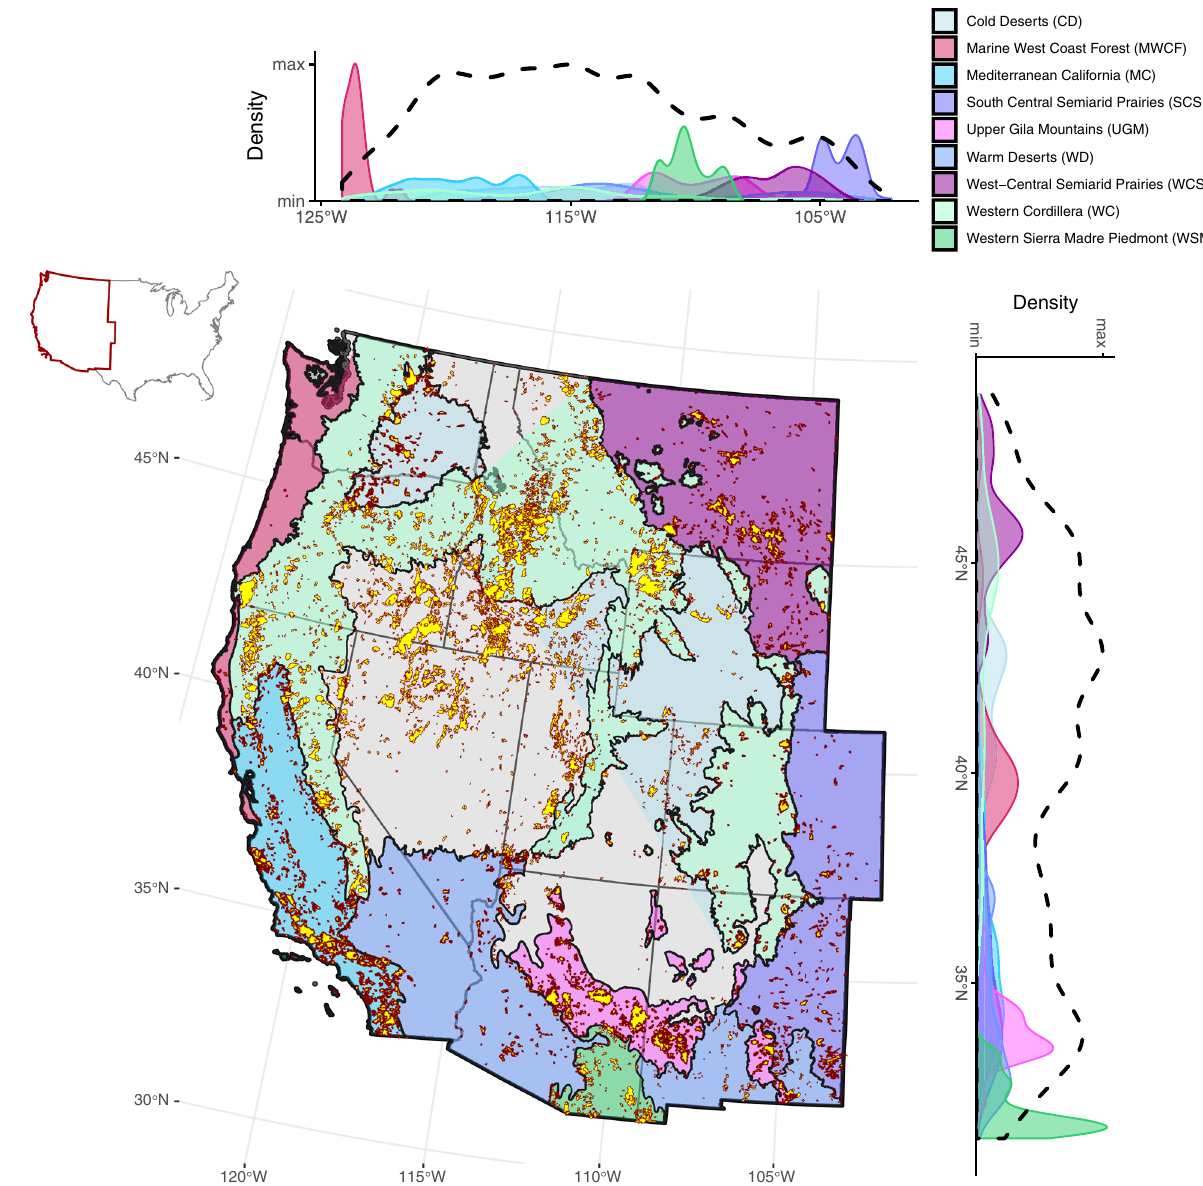
Fig. 1 Spatial distribution of wild fi res across the western conterminous US. Data span from 1984 – 2014. Burn scars are fi lled in yellow and outlined in red. Kernel density plots show the latitudinal and longitudinal distribution of Stream + river Length impacted within Burned Areas (SL BA ) for the full dataset (dashed lines) and by ecoregion (shaded